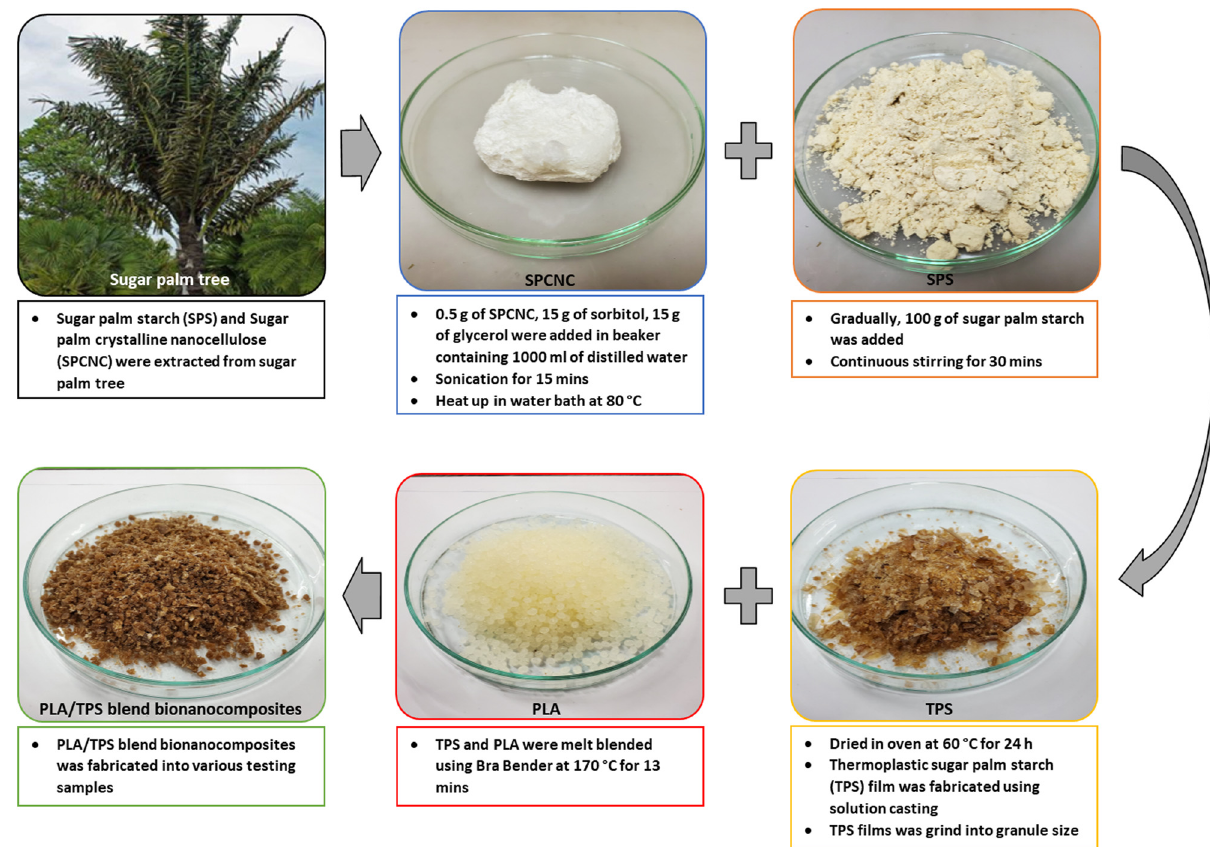
Figure 1: Schematic representation of overall process to prepare PLA/TPS blend